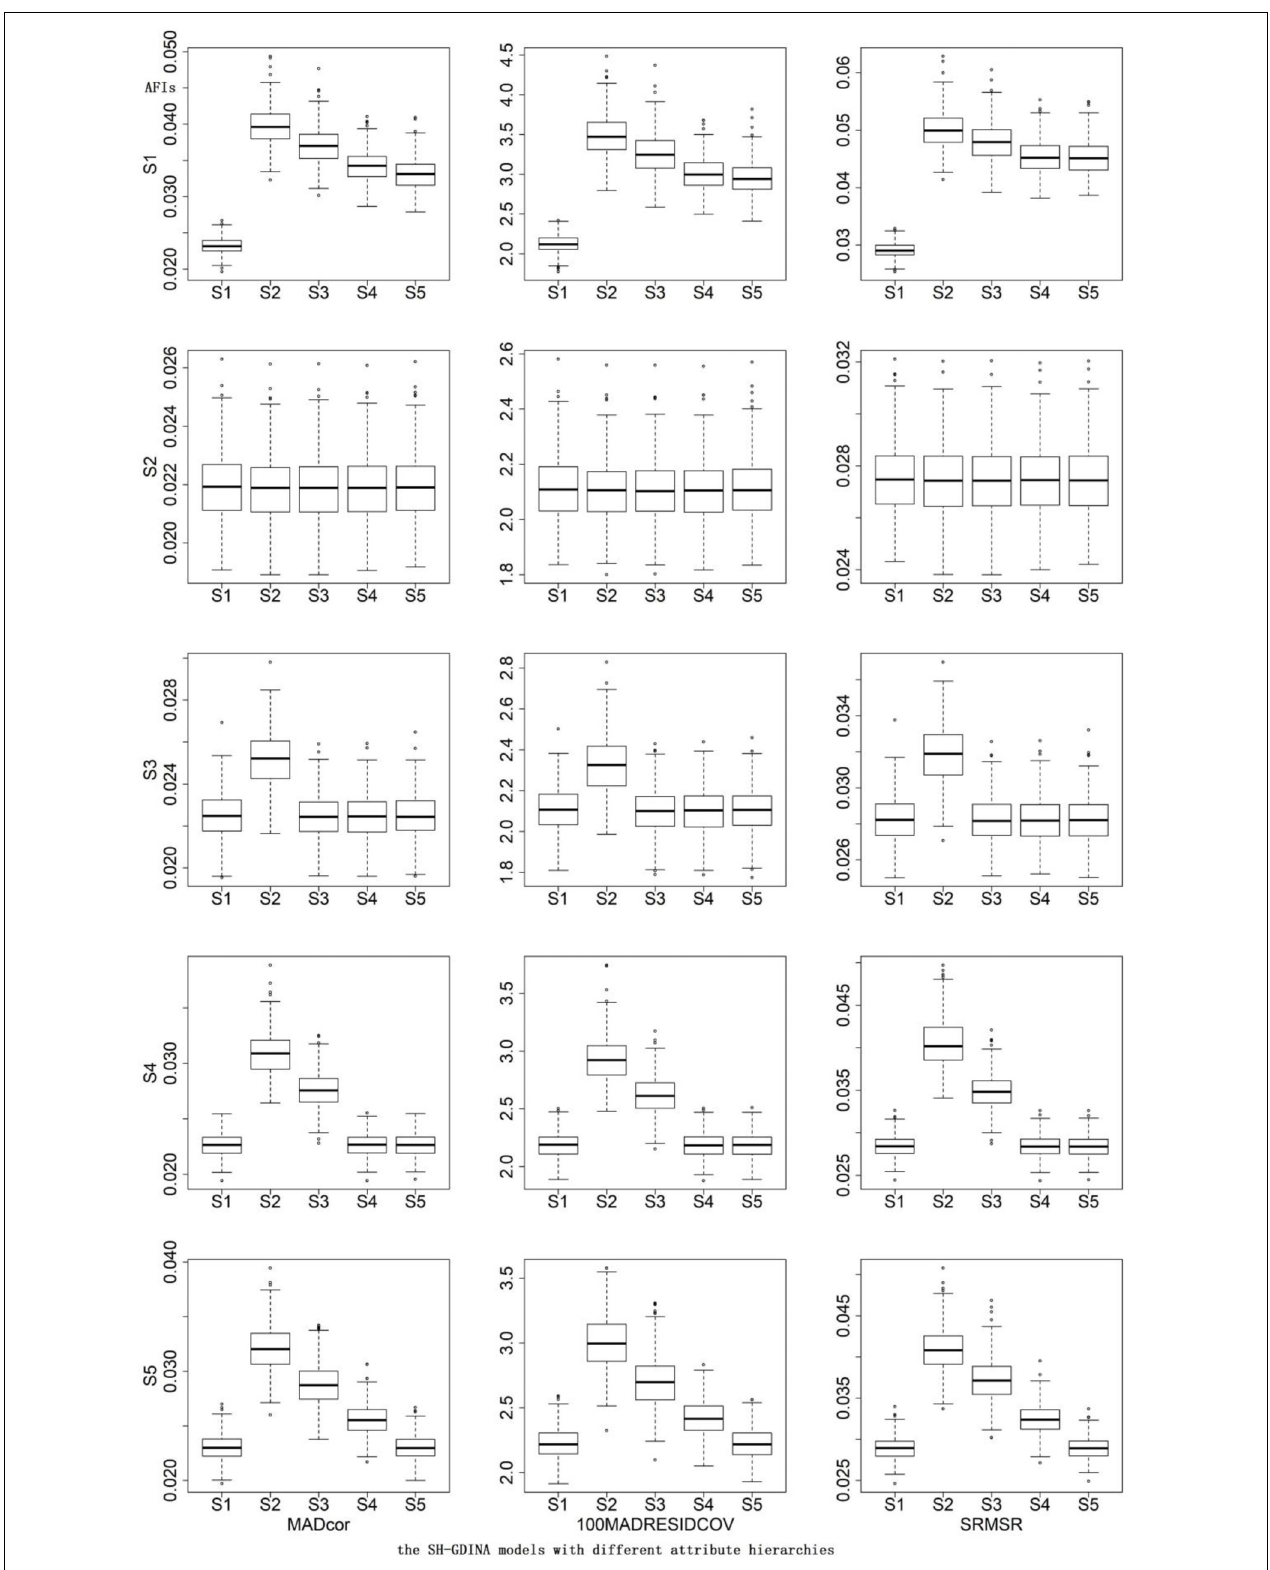
FIGURE 2 | Box plots of absolute fit indices (AFIs) in low item quality cases of simulation study II.